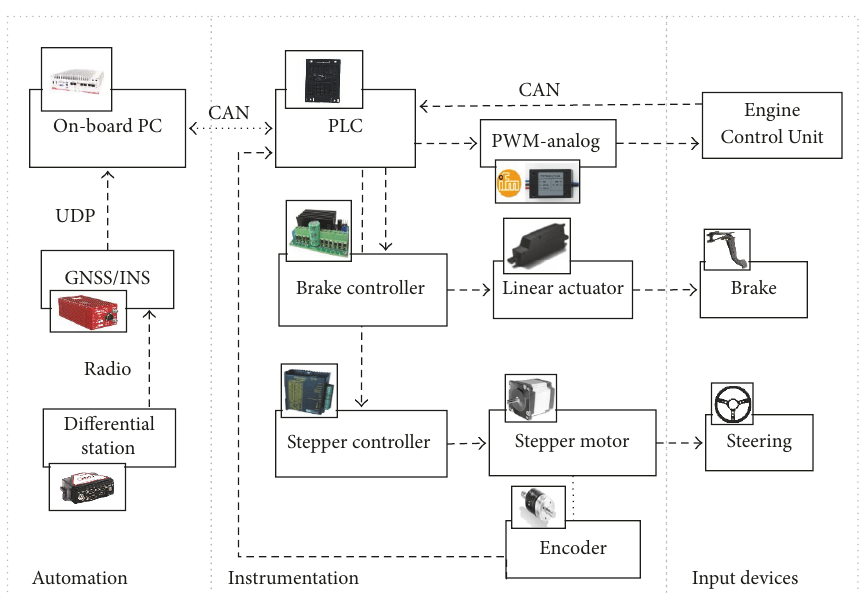
Figure 2: Instrumentation and automation of a Renault